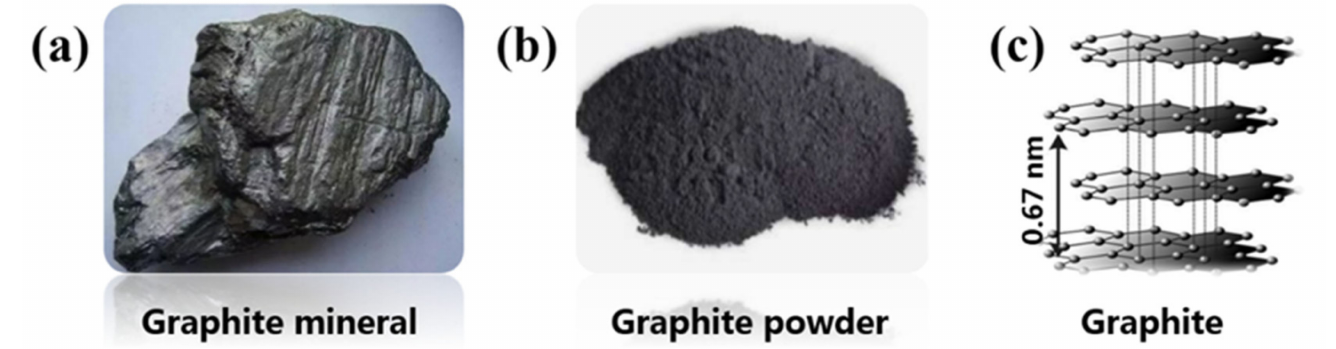
Figure 4. Photographs of ( a ) graphite mineral, ( b ) flake graphite powder, ( c ) crystalline structure of